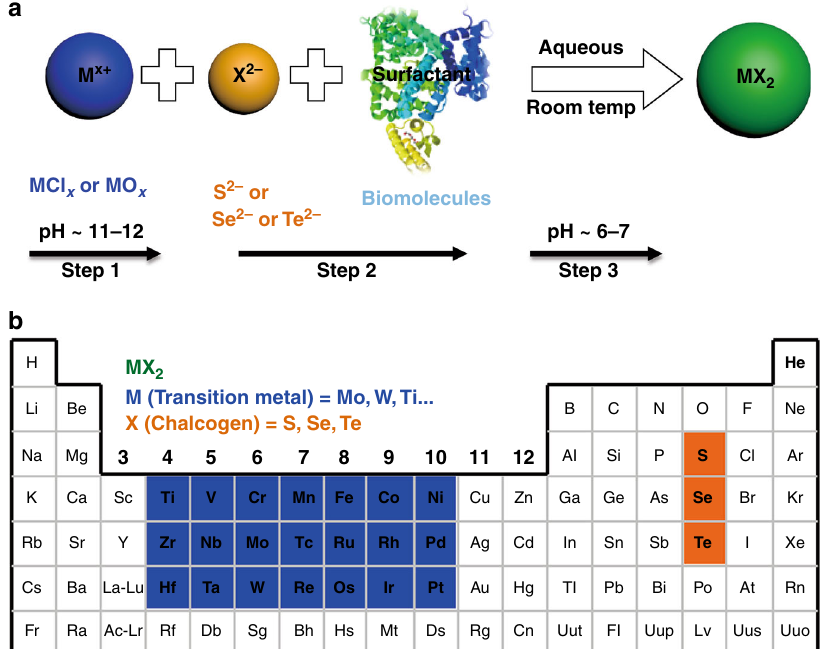
Fig. 3 Illustration of the bottom-up synthesis of TMD QDs under mild condition. a In this study, only the synthesis of commonly reported TMDs (MoS 2 , WS 2 , RuS 2 , MoTe 2 , MoSe 2 , WSe 2 and RuSe 2 ) QDs were showed. b Extrapolating the synthesis method to other TMD QDs synthesis